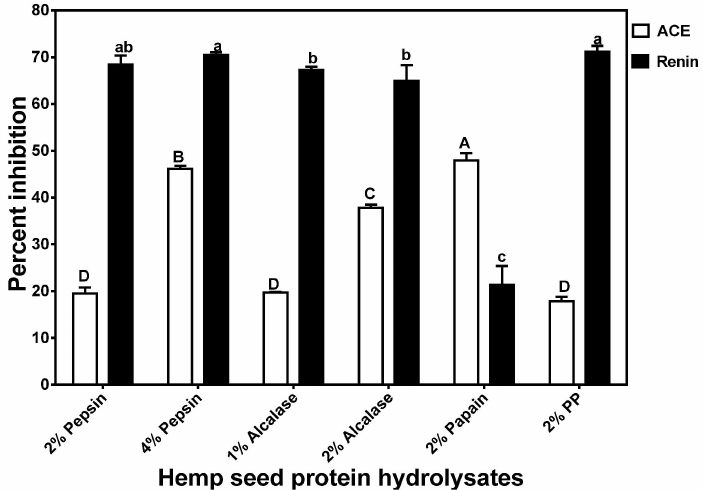
Figure 4. Inhibition of renin and angiotensin converting enzyme (ACE) by enzymatic hemp protein hydrolysates.